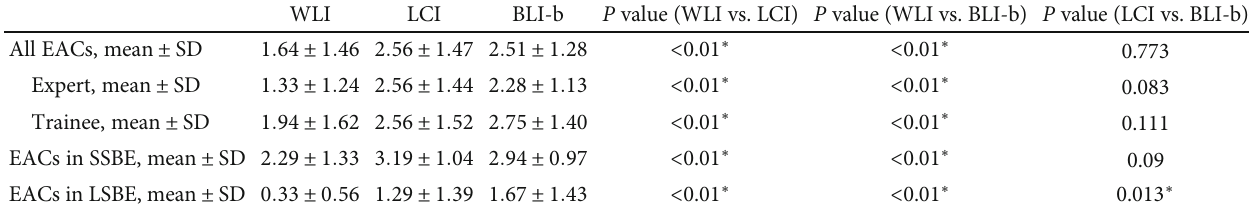
Table 4: The mean visibility scores of EAC in WLI, LCI, and BLI-b modes. WLI LCI BLI-b